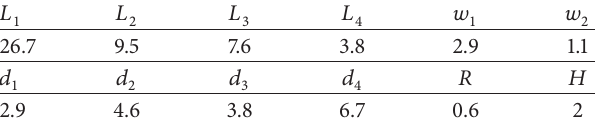
Table 1: Parameters of spiral slot patch antenna (unit: mm).